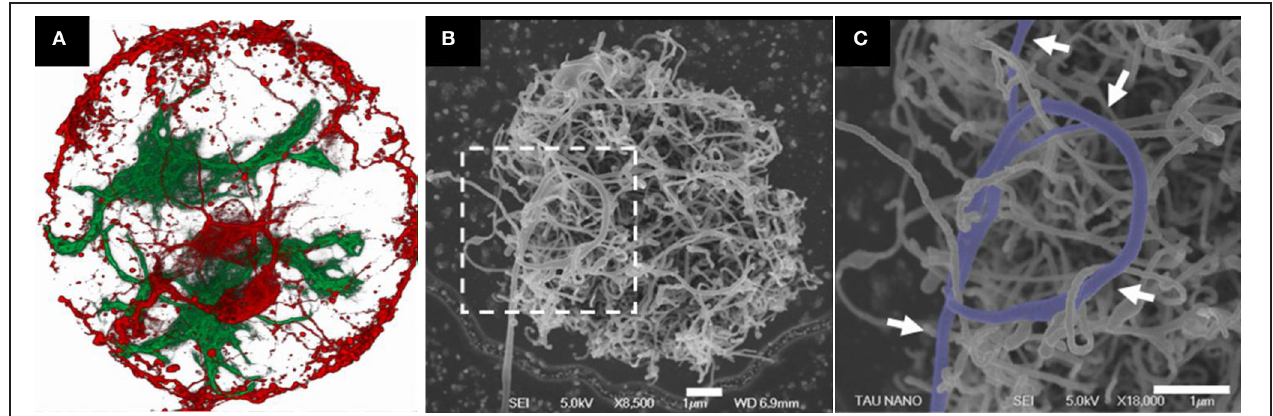
image in (C) corresponds to the area marked by the dashed box in (B) . Clearly identifiable process segments were manually highlighted. Processes appear to bind to the carbon nanotube surface in a manner akin to that of tendrils. Adopted from Sorkin et al.